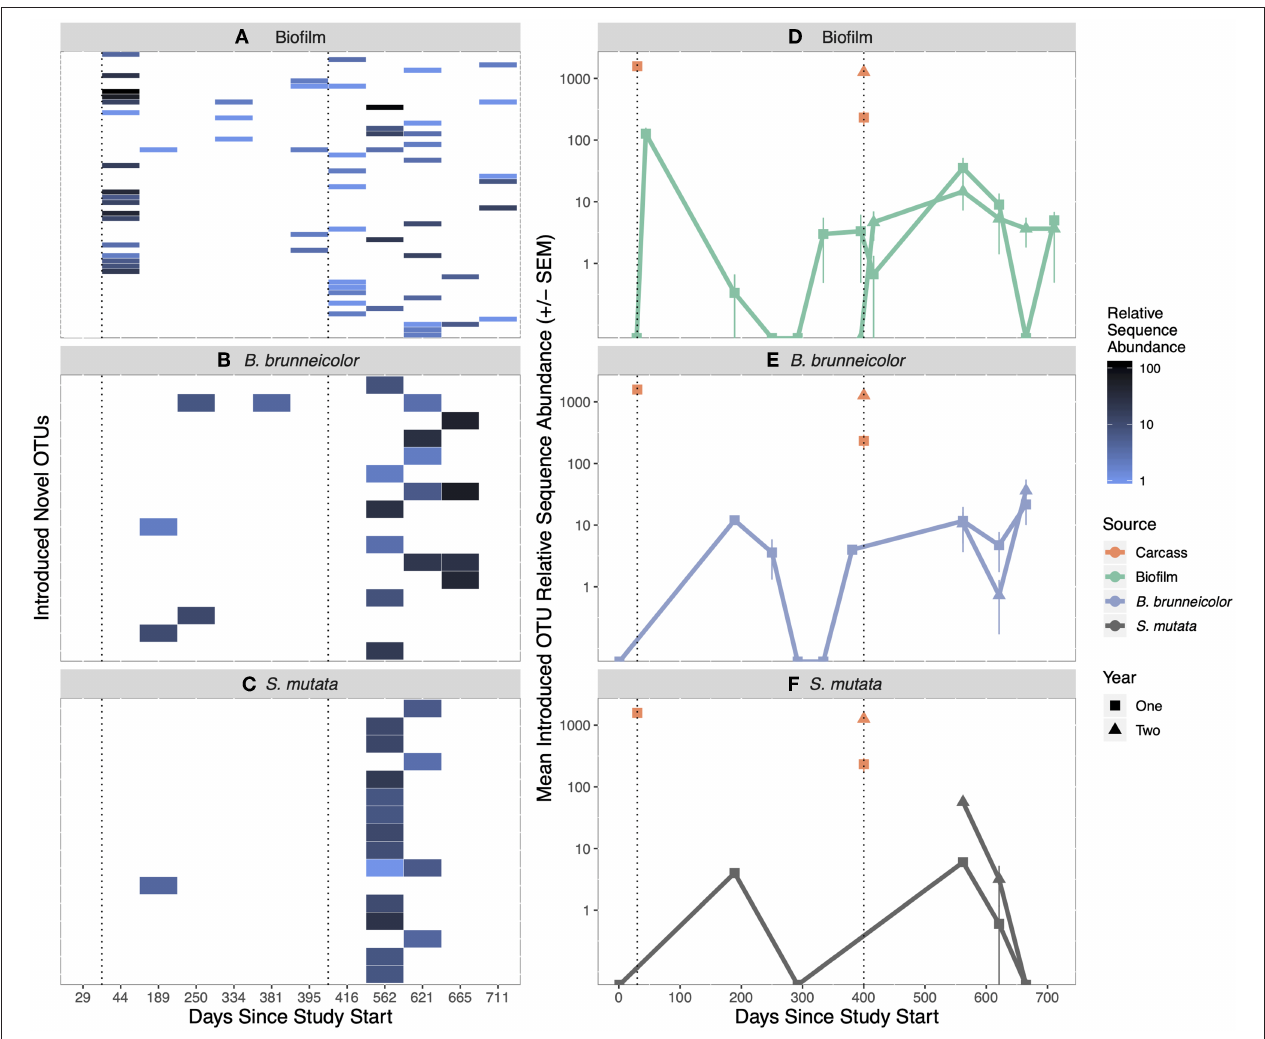
FIGURE 3 | Heatmap of unique salmon carrion introduced OTUs found in treatment biofilm (A) , internal B. brunneicolor (C) , and internal S. mutata (E) after carcass introduction. Each y-axis row on the heatmap represents one unique salmon carrion introduced OTU. White color in heatmaps represents zero observations. Mean introduced OTU abundance ( ± SEM) in salmon carcasses and biofilms (B) , internal B. brunneicolor (D) , and internal S. mutata (F) , over time. The orange carcass points represent the unique OTUs introduced to the stream for that year. The carcasses added in year 2 contained OTU’s previously introduced in year 1 (orange square), as well as new OTU’s not previously found in biofilm or insect samples (orange triangle). The sample (biofilm, internal B. brunneicolor , or internal S. mutata ) points (in green, purple or gray, respectively) represent the amount of that year’s salmon introduced OTUs found in biofilm samples. Black, dotted vertical lines represent the day of salmon introduction. Relative sequence abundance is the number of reads in the rarefied (2,500 reads)